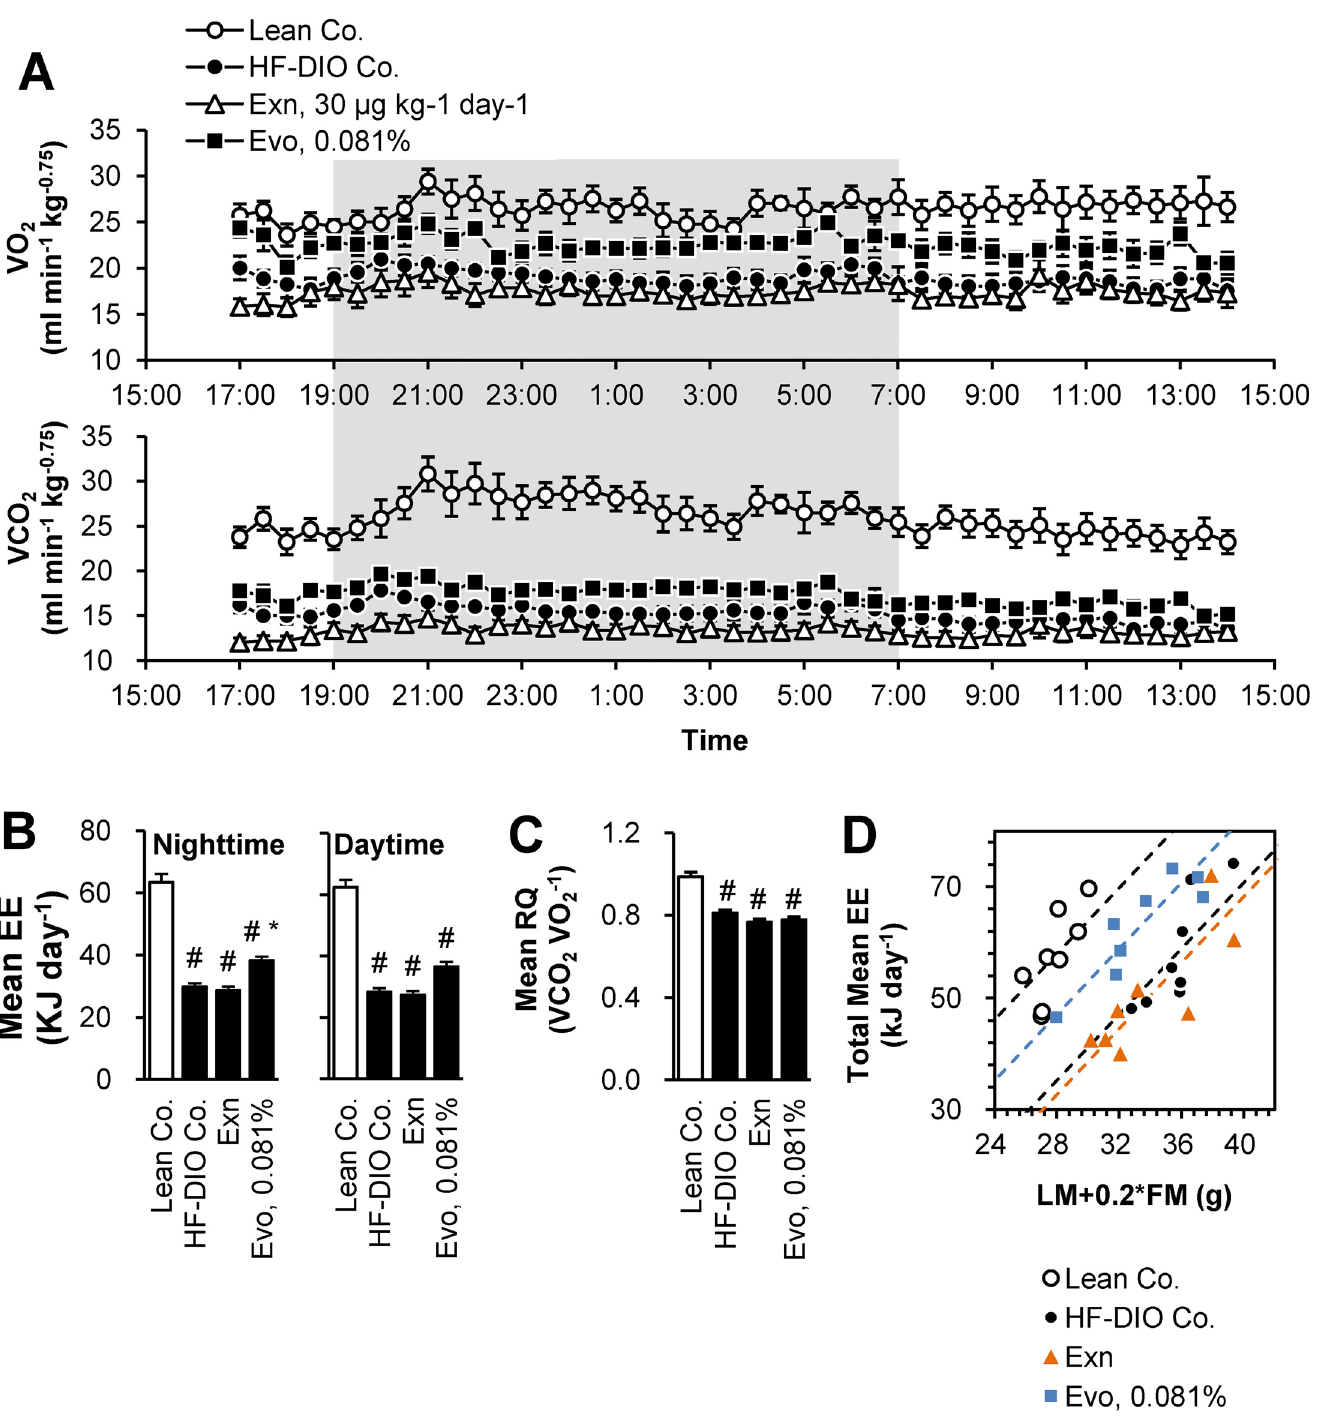
Fig 4. Evogliptin increased energy expenditure unlike exenatide. HF-DIO mice were treated with exenatide (30 μ g kg -1 , once daily, s.c.) or evogliptin at 0.081% (w/w) for 2 weeks. Metabolic parameters were measured using an indirect calorimetry system; (A) Oxygen consumption (VO 2 ) and carbon dioxide production (VCO 2 ), (B) mean energy expenditure (EE), (C) respiratory quotient (Rq), and (D) a plot of individual data of total mean EE vs. (lean mass + 0.2 × fat mass) as a covariate (n = 8/group). #, P < 0.05 vs. lean control and * , P < 0.05 vs. HF-DIO control by one-way ANOVA.